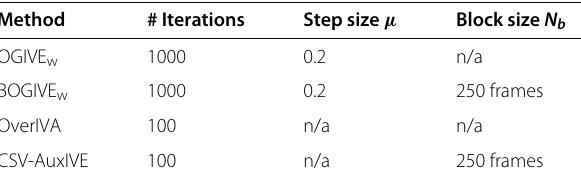
Table 1 Parameter setup for the tested methods in the simulated room